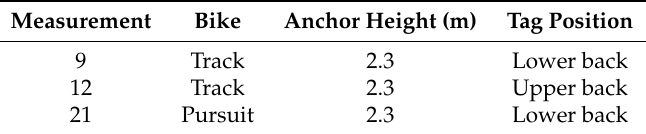
Table 2. Overview configurations with all anchors’